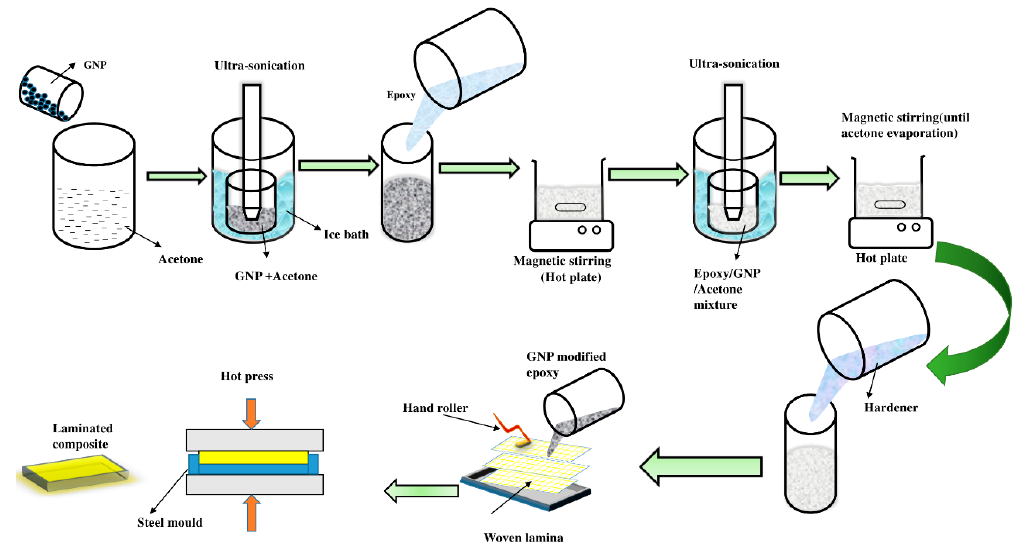
Figure 4. The GNP dispersion into the epoxy matrix. Table 3. The specification of the laminates .